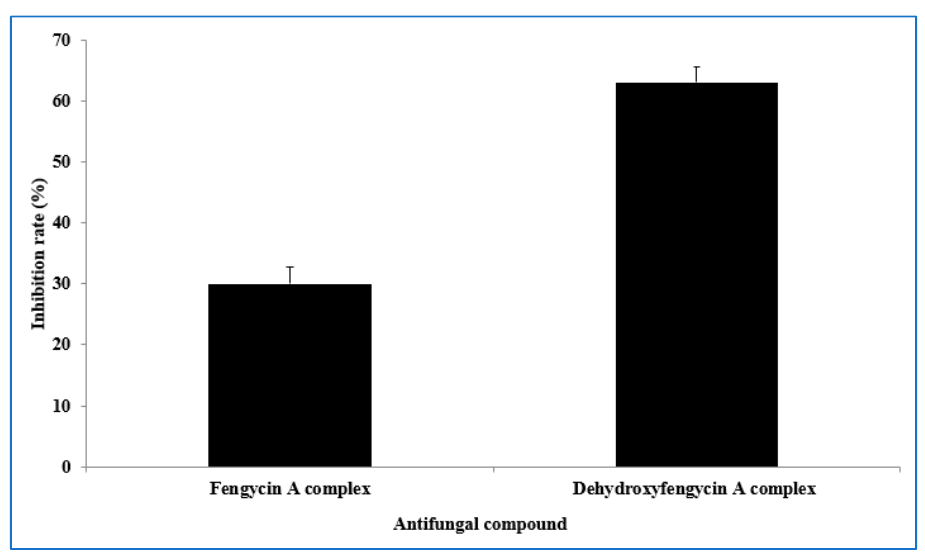
Figure 4. Inhibition of Rhizoctonia solani mycelial growth by fengycin A (compound 1 ) and dehydroxyfengycin A (compound 2 ) extracted from Bacillus subtilis SA-15. Values are means and standard errors of three replicates.